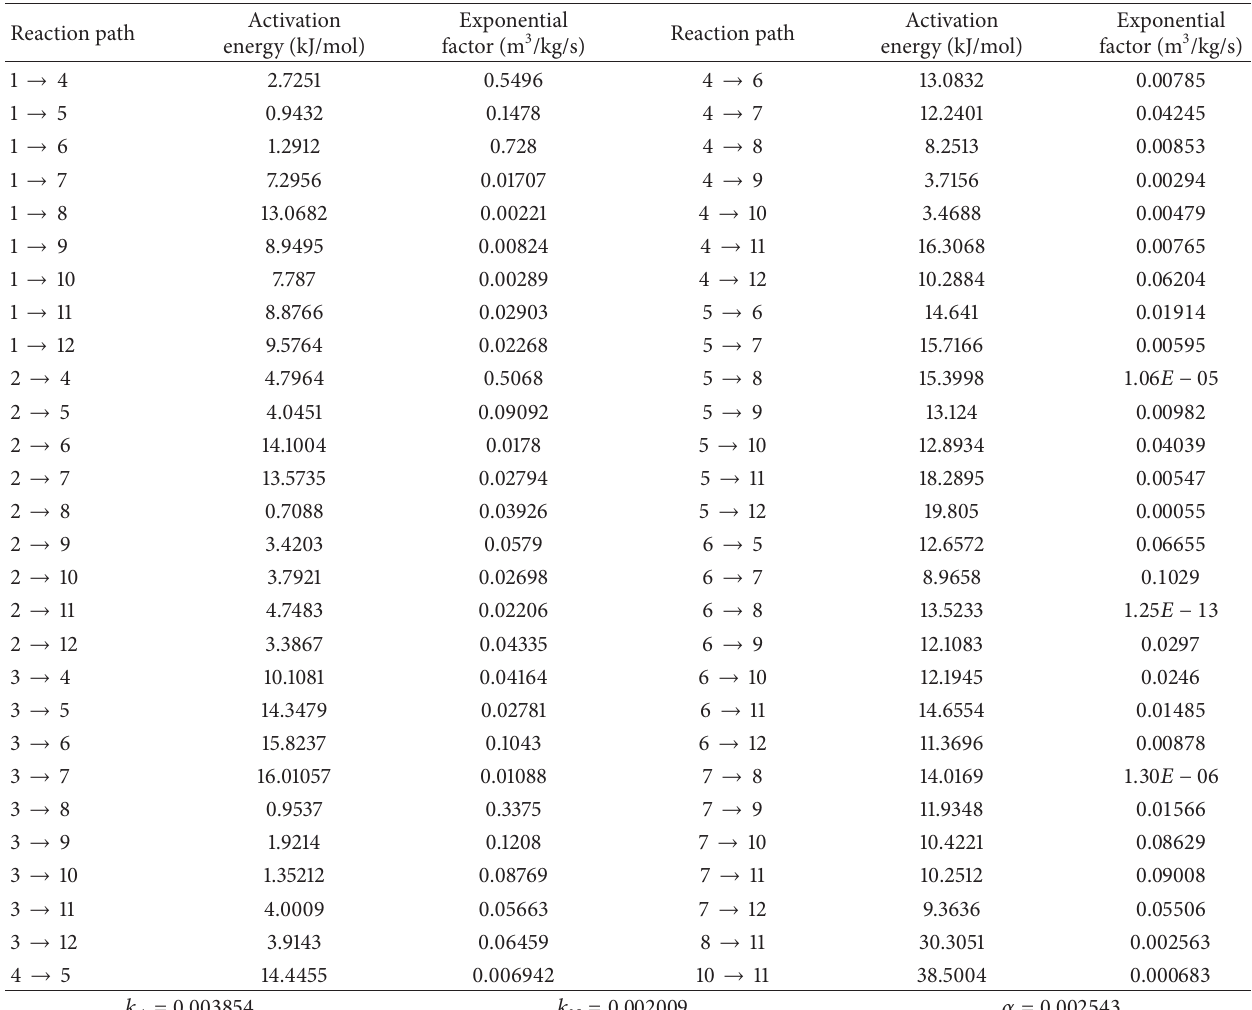
Table 4: Kinetics constants and activation energies of reaction [6, 14].